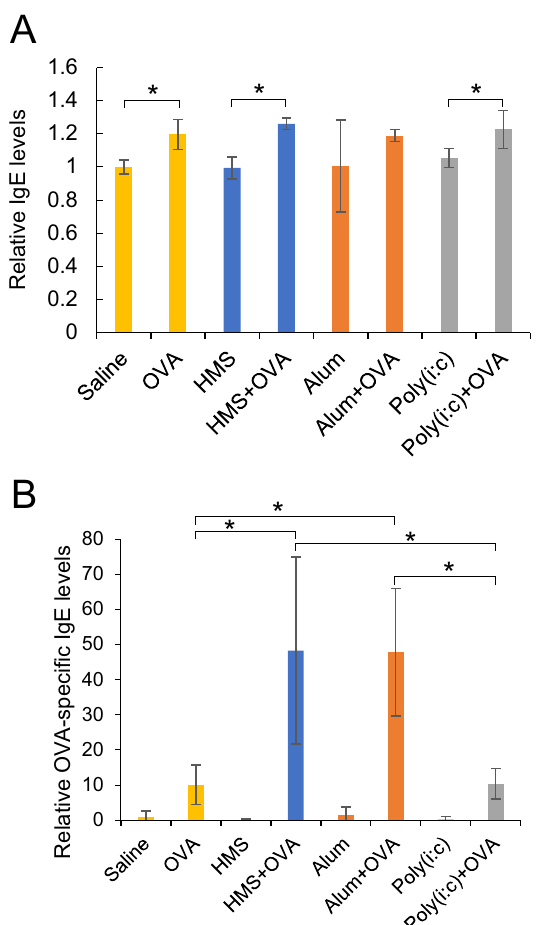
Fig. 6 IgE induction in mice subcutaneously administered with HMS particles, Alum, or Poly(i:c). A Total IgE levels. B Ovalbumin (OVA) speci fi c IgE levels. * p < 0.05 Student ’ s t